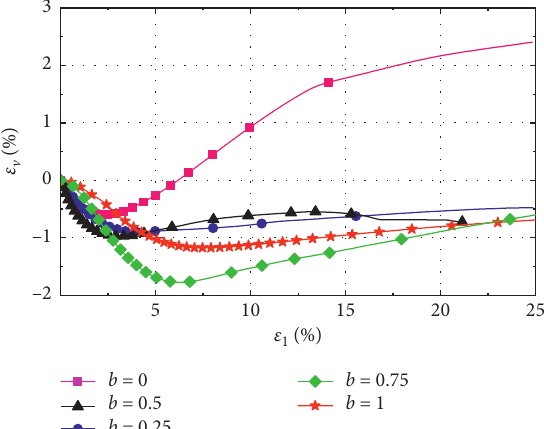
Figure 10: The relationships of ε